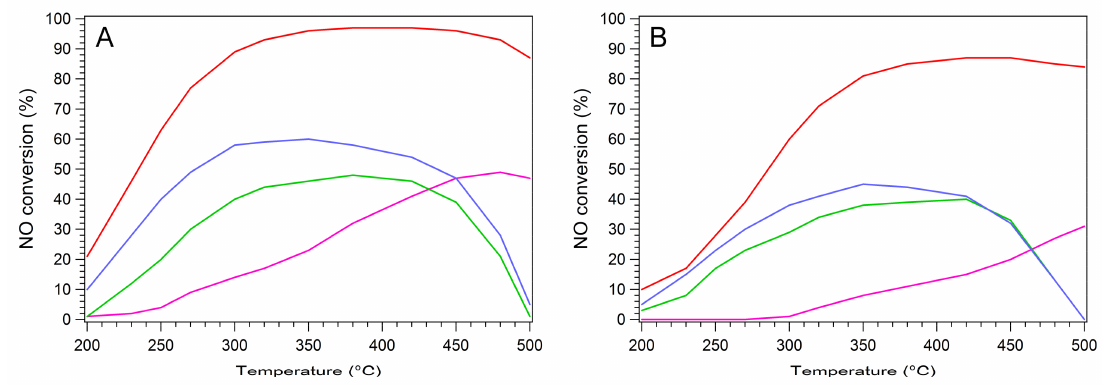
Figure 5. NO conversion in NH 3 -SCR over ( A ) FeVO 4 (8.4 wt %) and ( B ) Fe 0.5 Er 0.5 VO 4 (8.4 wt %) loaded on different supports. Red lines: TWS, blue lines: Ce 0.75 Zr 0.25 O 2 , green lines: CeO 2 , magenta lines: Al 2 O 3